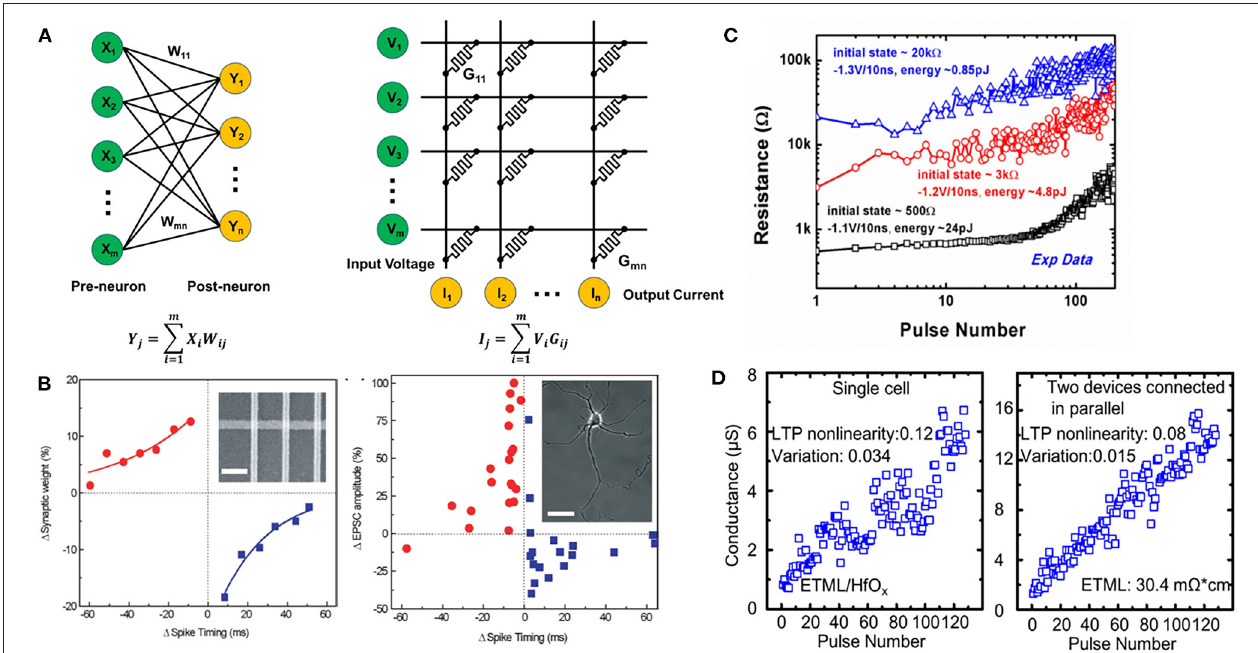
FIGURE 6 | (A) Schematic of the RRAM-based neural network. (B) Demonstration of the spike time-/rate-dependent plasticity (STDP) in the RRAM-based synapse and the excitatory postsynaptic current of rat hippocampal neurons. (C) Measured gradual training process of RRAM under consecutive identical pulses. (D) Improved linearity of conductance tuning in RRAM synaptic devices by introducing an electro-thermal modulation layer. Reprinted from Wu et al. (2018), Yu et al. (2012), and Jo et al. (2010)